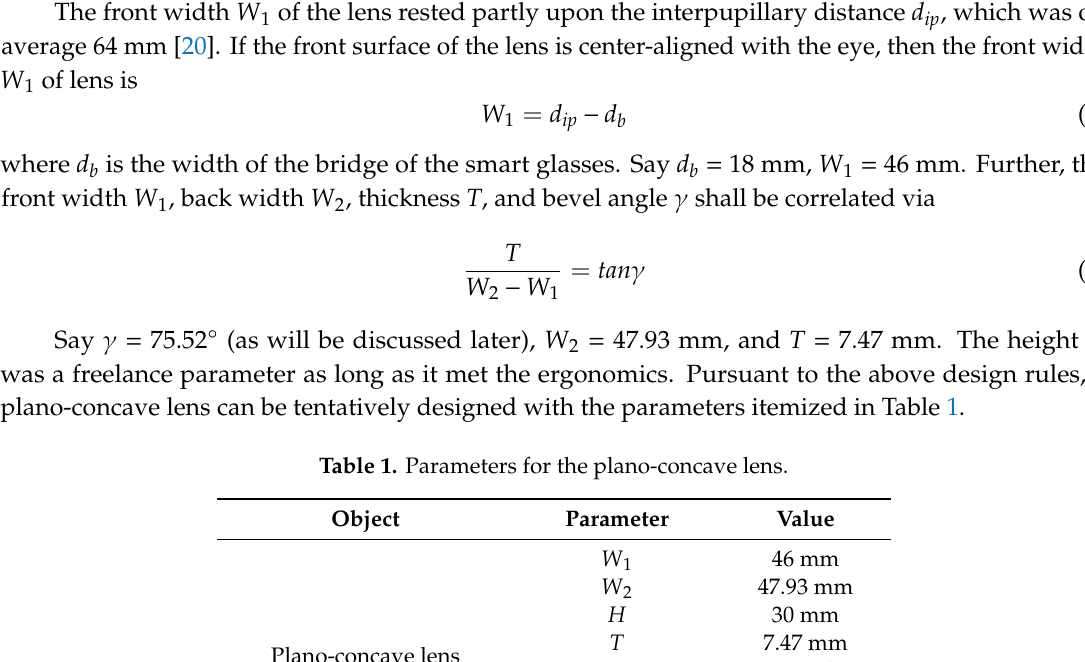
Figure 2. Optical path diagram for imaging the real object. R is the radius of curvature of the front surface of lens, s r the real object distance, and s (cid:48) the image distance.